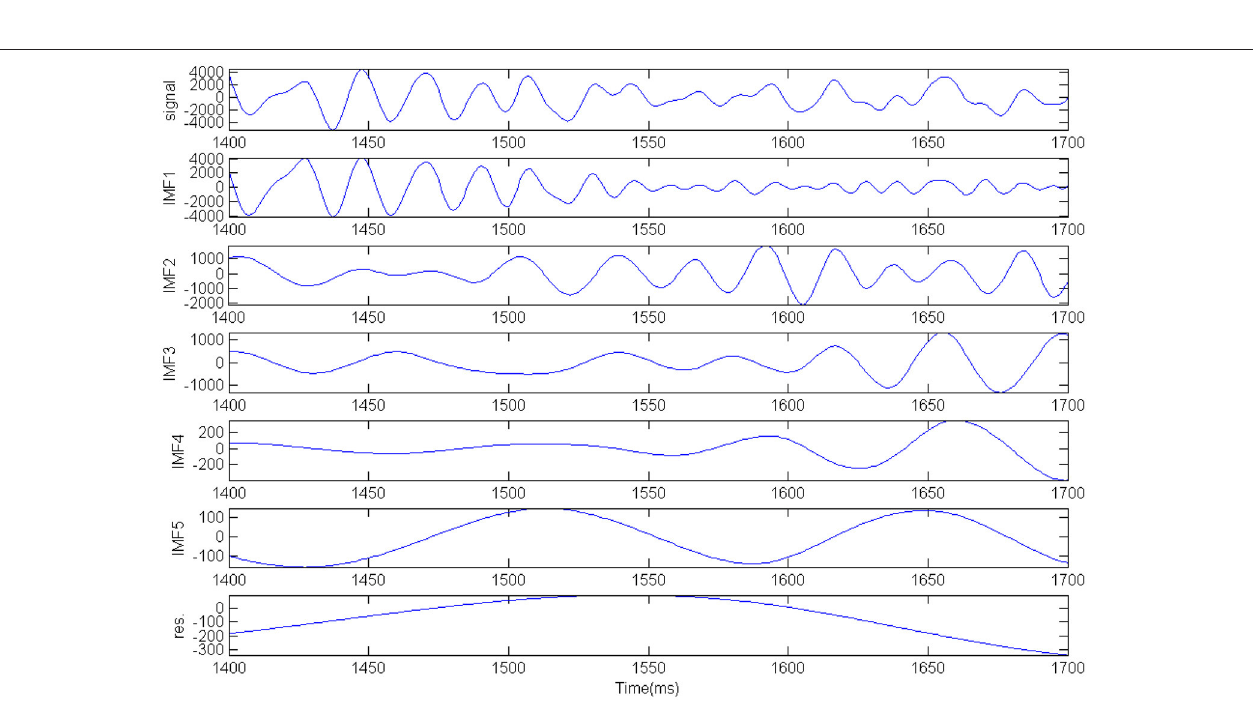
FIGURE 7 | EMD applied to the seismic trace intersecting well